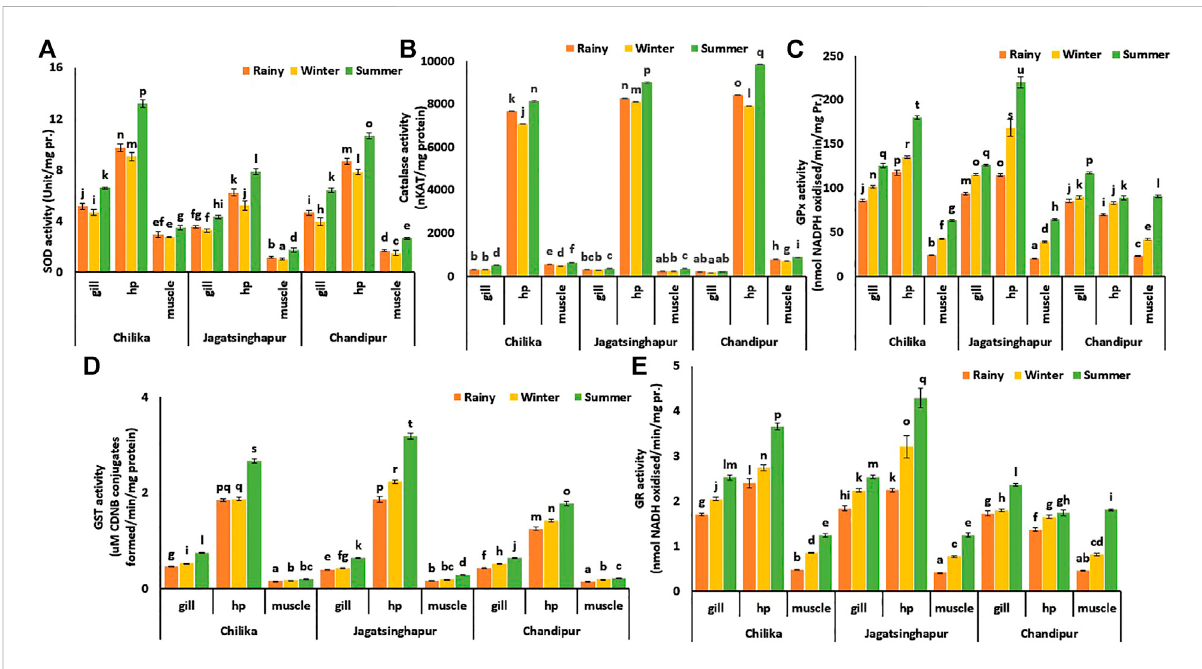
FIGURE 3 Spatiotemporalvariationoftissue-speci fi credoxregulatoryandglutathioneenzymesin Scyllaserrata. (A) SOD, (B) GPx, (C) CAT, (D) GR,and (E) GST activity in tissues of S. serrata . Data are presented as the mean ± S.D. (n = 10). MANOVA followed to compare the means. Different letters above the bars denote the statistical differences between mean values at p <